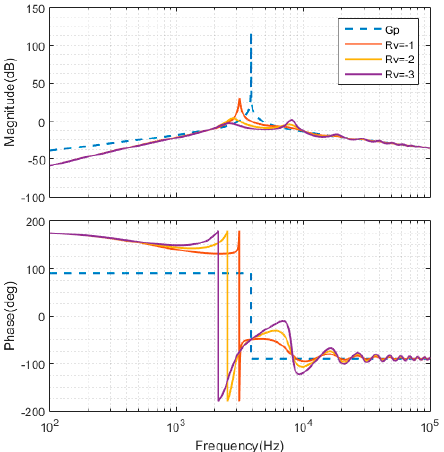
Figure 11. i L or i c feedback based virtual negative resistor with delay considered.